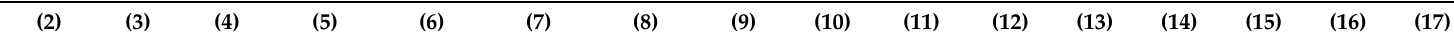
Table A2. Matrix of